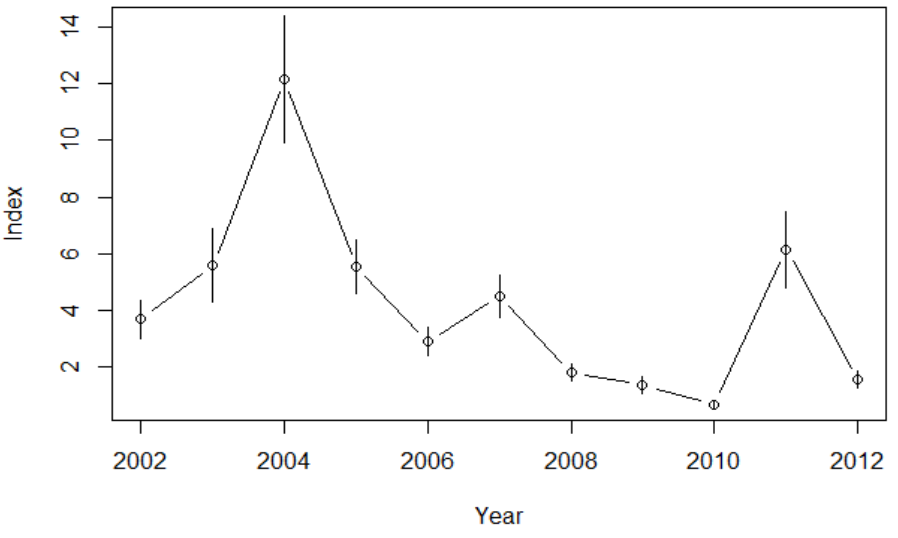
Figure 23. Index of relative abundance of female horseshoe crabs (delta mean crabs per sampling event) developed from the spring portion of New Hampshire’s Spawning Beach Survey with 95% confidence intervals.